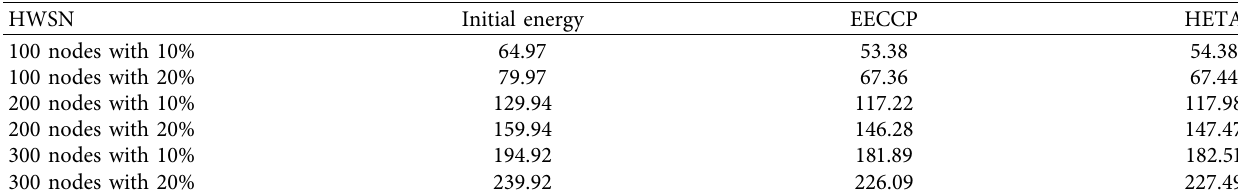
Table 4: Residual energy (in Joules) after 5000 transmission